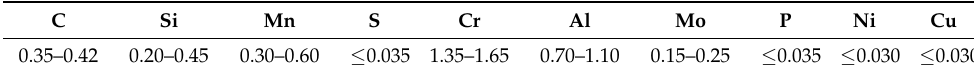
Table 2. Chemical composition of 38CrMoAl steel